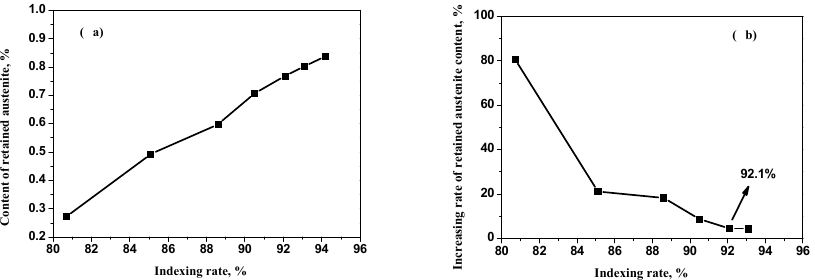
Figure 4. Curves of the measured retained austenite content ( a ) in X90 steel and its increasing rate ( b ) with indexing rate.